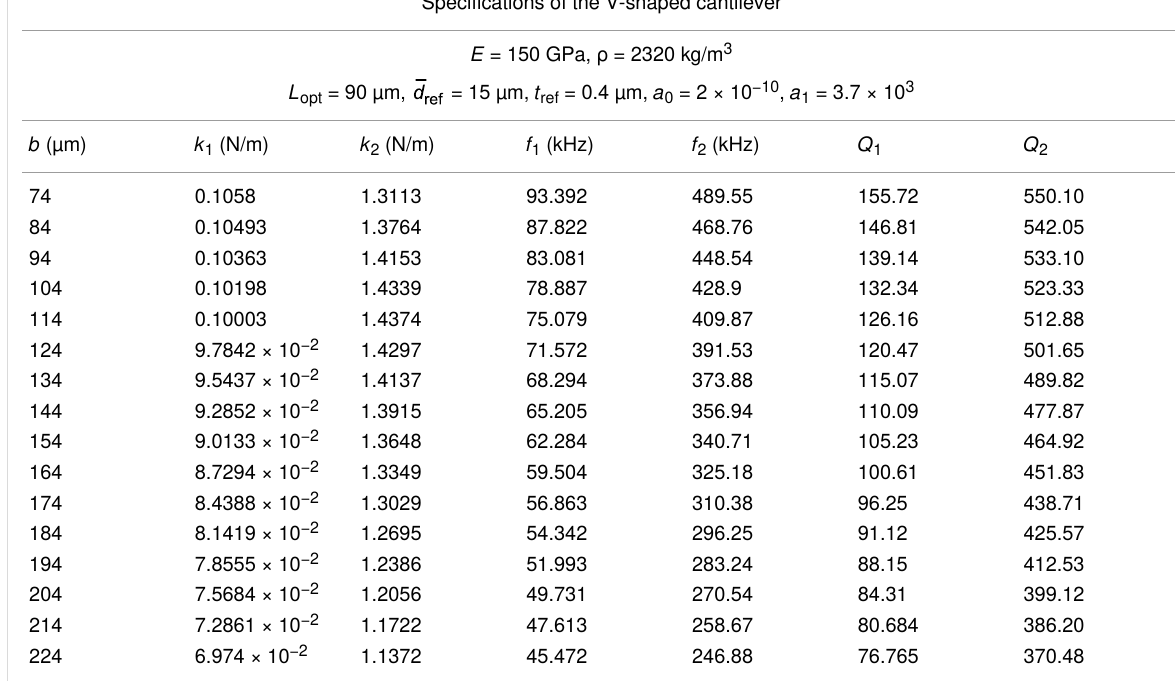
Table 3: Range of base widths ( b ) for V-shaped cantilevers with calculated properties. Specifications of the V-shaped